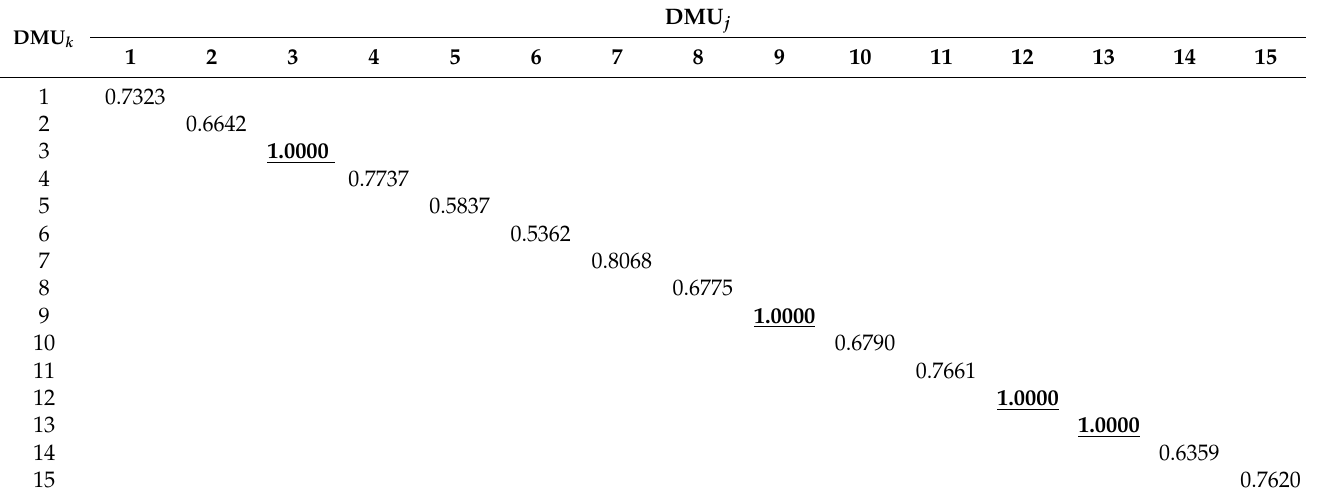
Table 3. Self-efficiencies of 15 DMUs in cross-efficiency matrix.